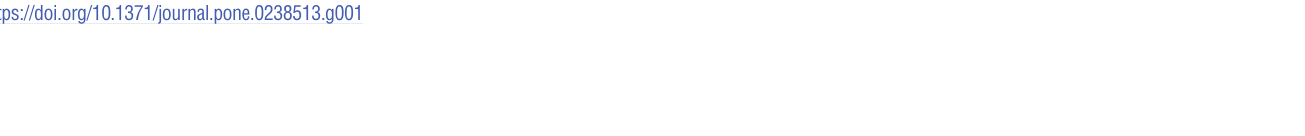
PLOS ONE | https://doi.org/10.1371/journal.pone.0238513 September 3,